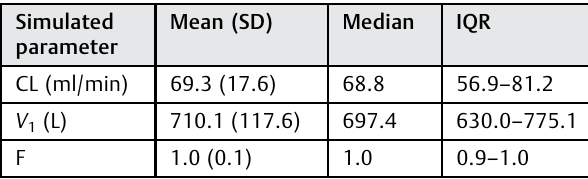
Table 2 Summary of simulated pharmacokinetic parameters ( n ¼ 65,233)